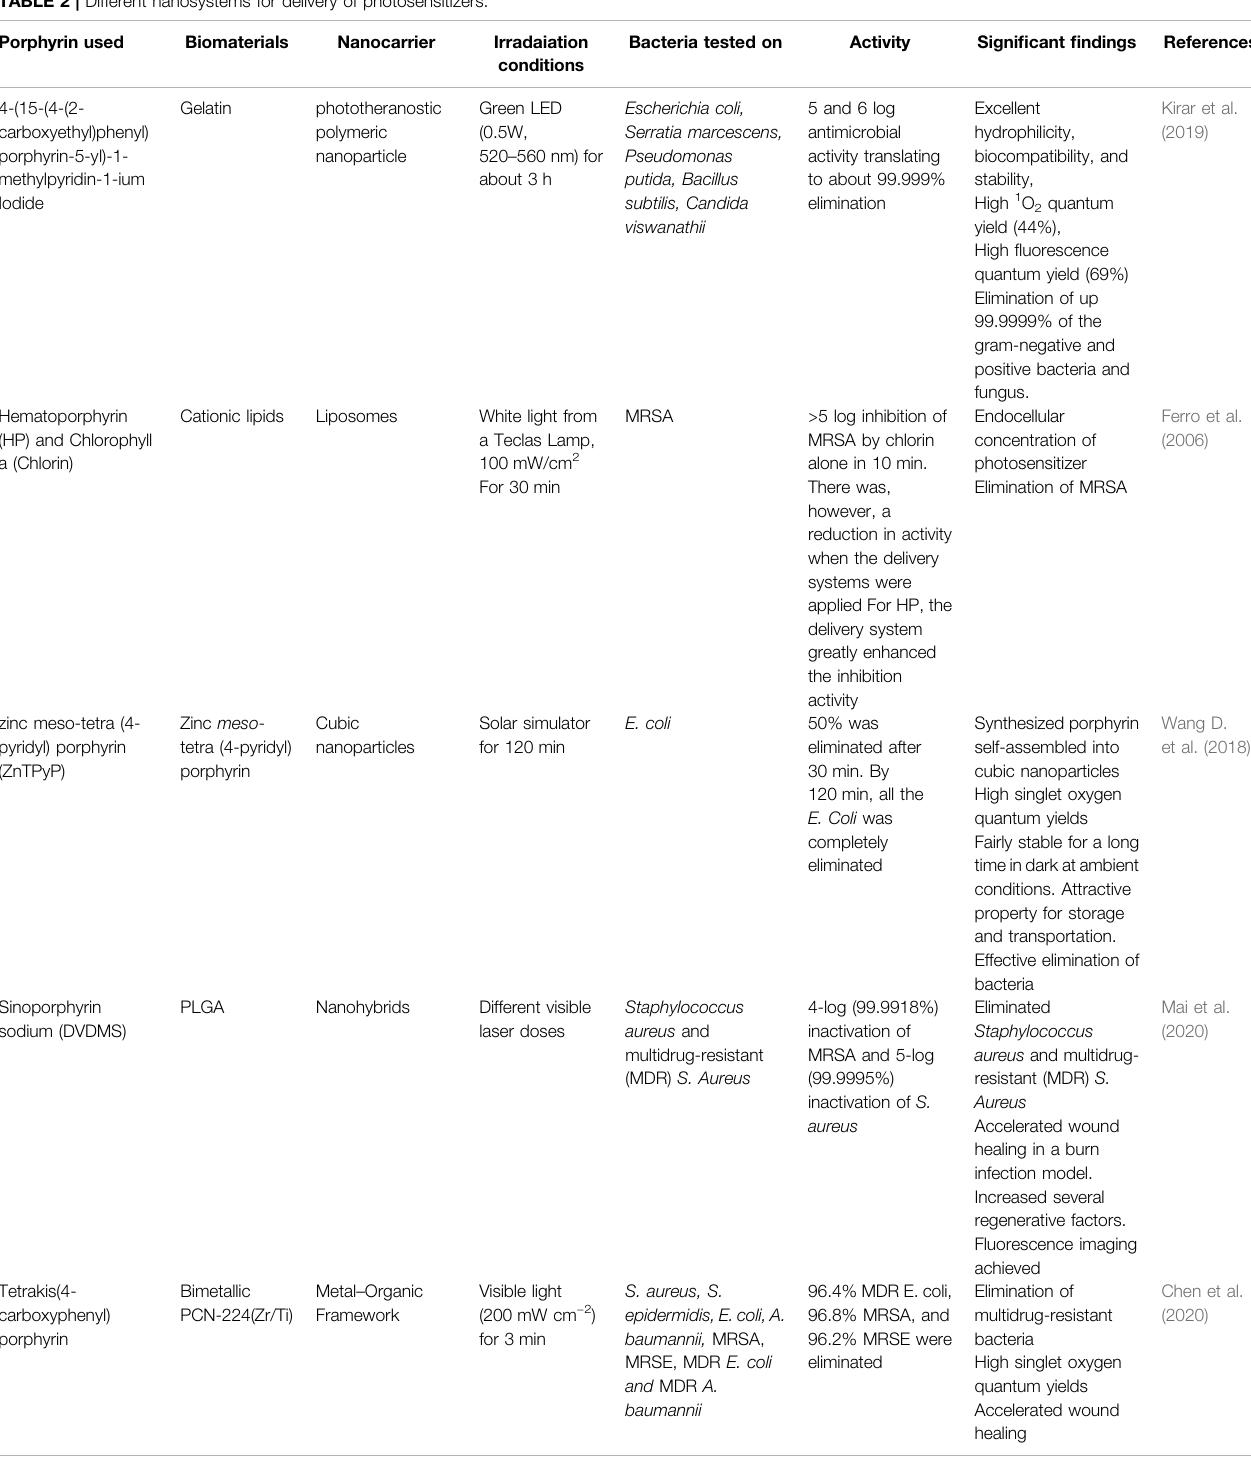
TABLE 2 | Different nanosystems for delivery of